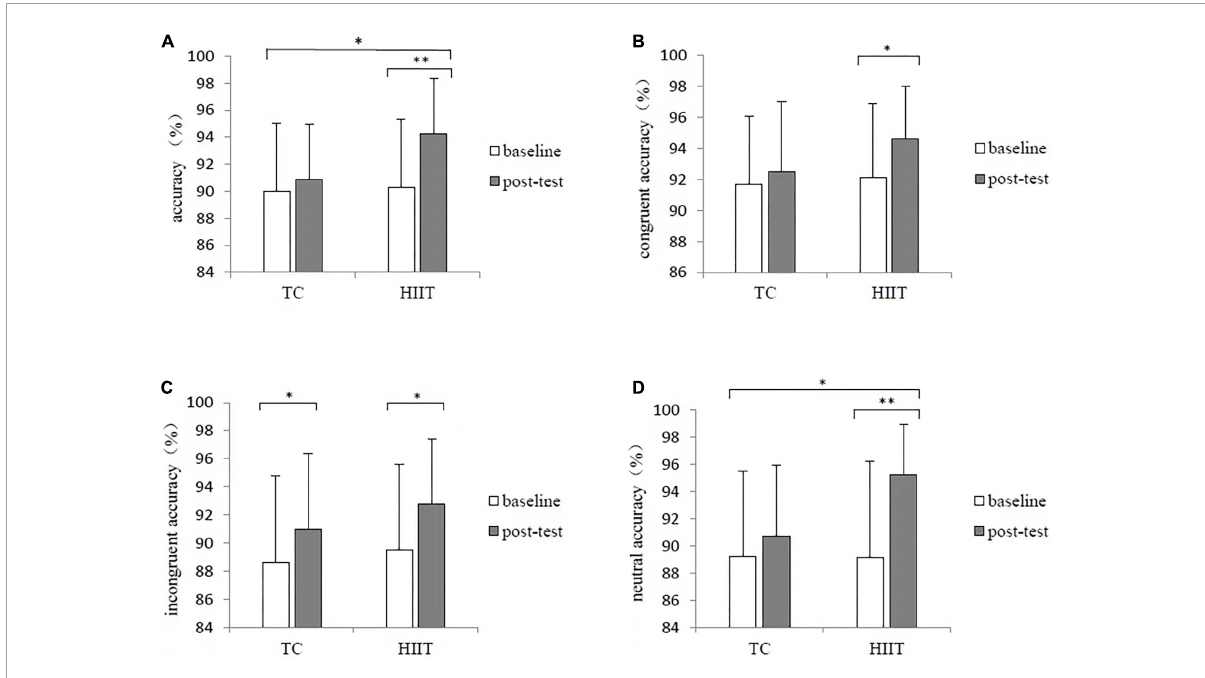
FIGURE3 Changes in the four accuracy conditions of the Stroop test after TC and HIIT: (A) accuracy in all conditions, (B) congruent accuracy, (C) incongruent accuracy, and (D) neutral accuracy. ∗ p < 0.05, ∗∗ p <